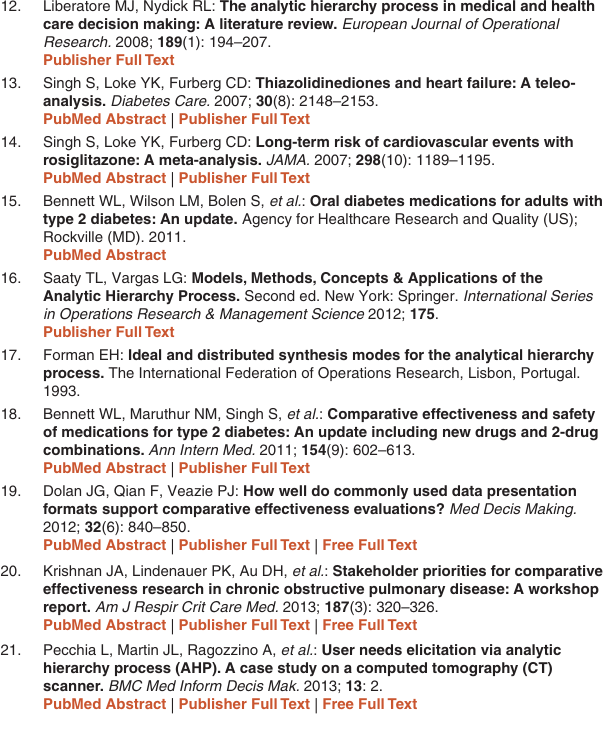
Figueira J, Greco S, Ehrgott M: Multiple Criteria Decision Analysis: State of the Art Surveys. New York: Springer 2005. Reference Source